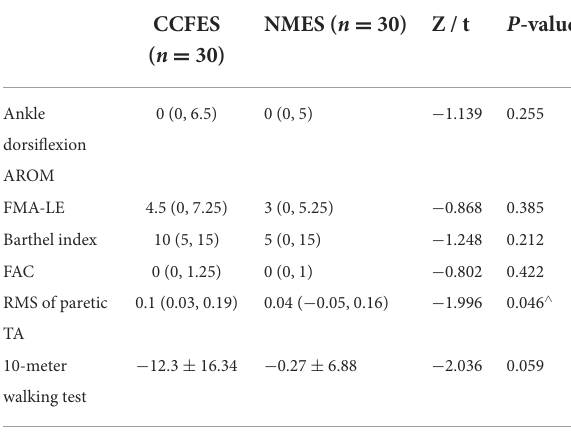
TABLE 3 Changes from baseline to end-of-intervention in functional assessments and sEMG.